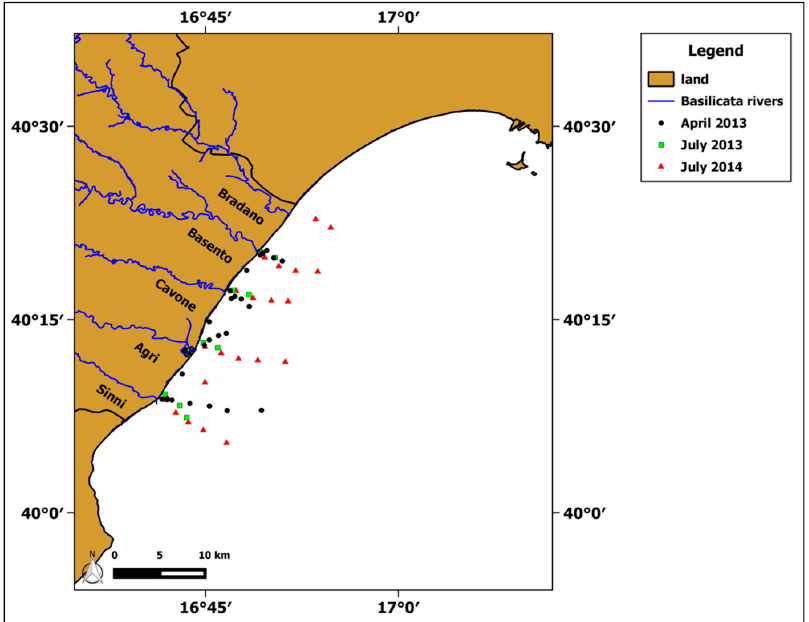
Figure 2. Sampling locations for each of the IOSMOS measurement campaigns.